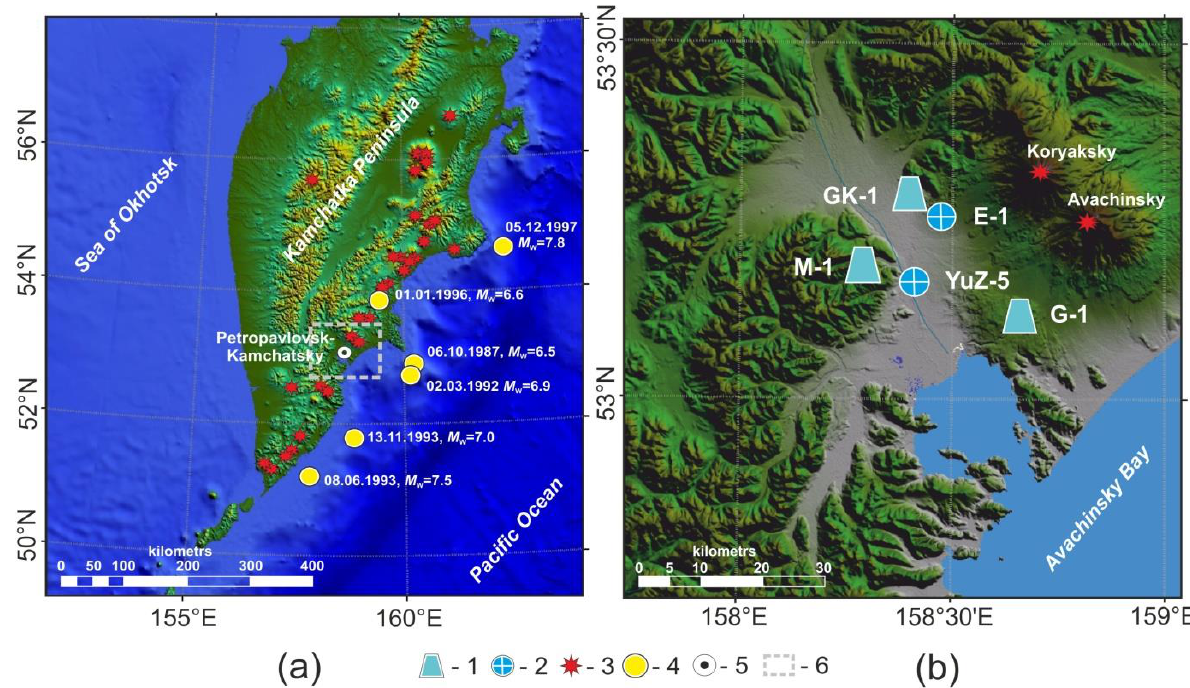
Figure 1. Layout of observation wells and earthquake epicenters: ( a ) earthquakes preceded by hydrogeochemical precursors; ( b ) observation wells at the Petropavlovsk-Kamchatsky test site. Designations: 1, flowing wells (Table 1); 2, piezometric wells; 3, active volcanoes; 4, earthquake epicenters (Table 2); 5, Petropavlovsk-Kamchatsky city; 6, Petropavlovsk-Kamchatsky test site in ( a ).